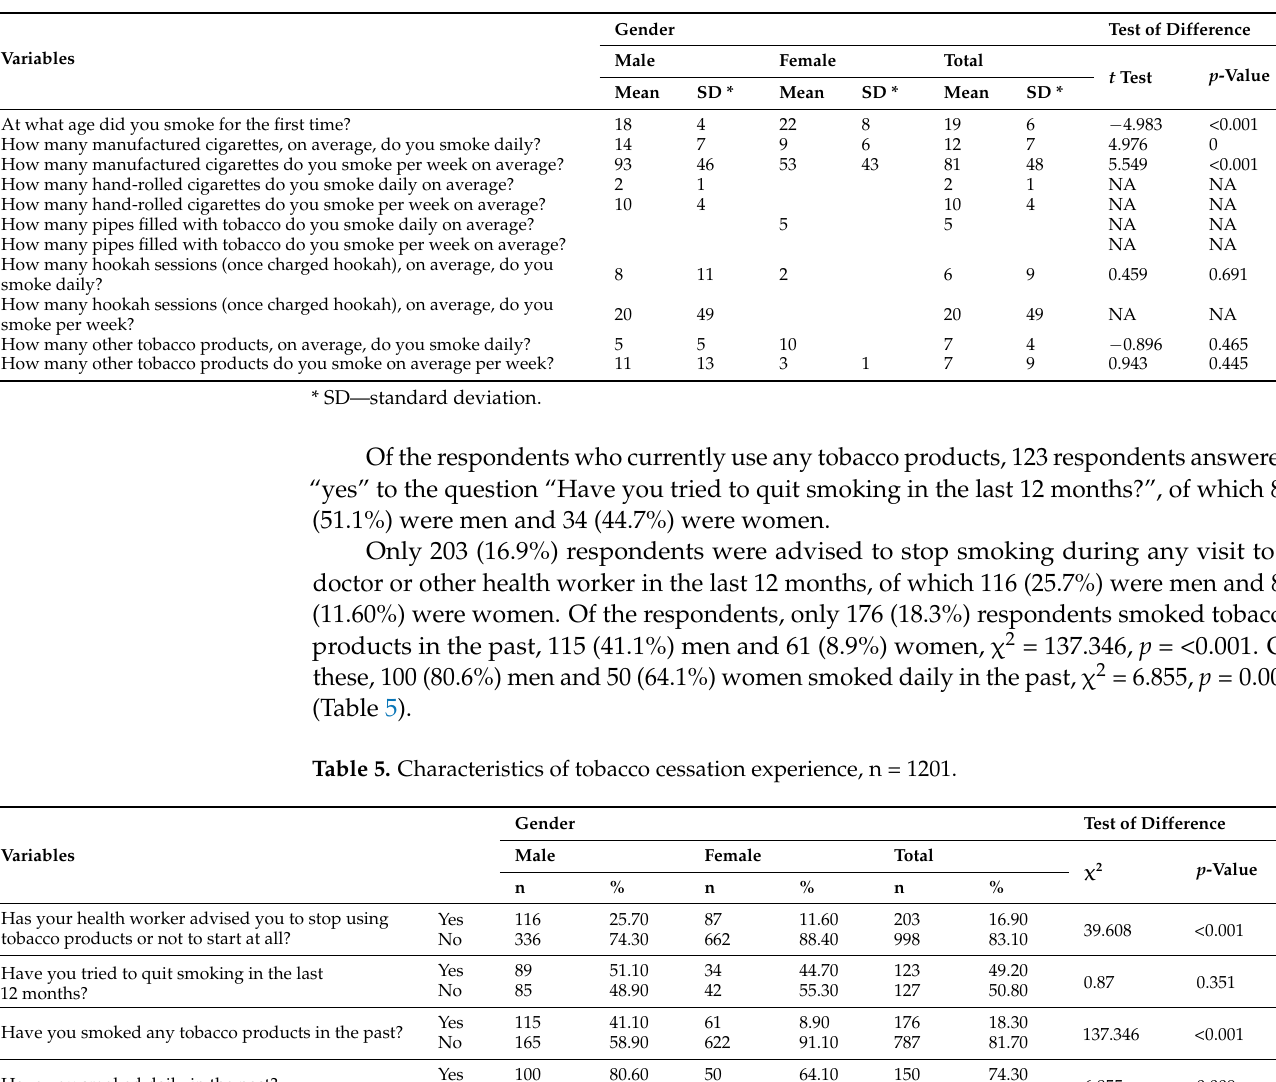
Table 4. Smoking status characteristics, n = 1201.